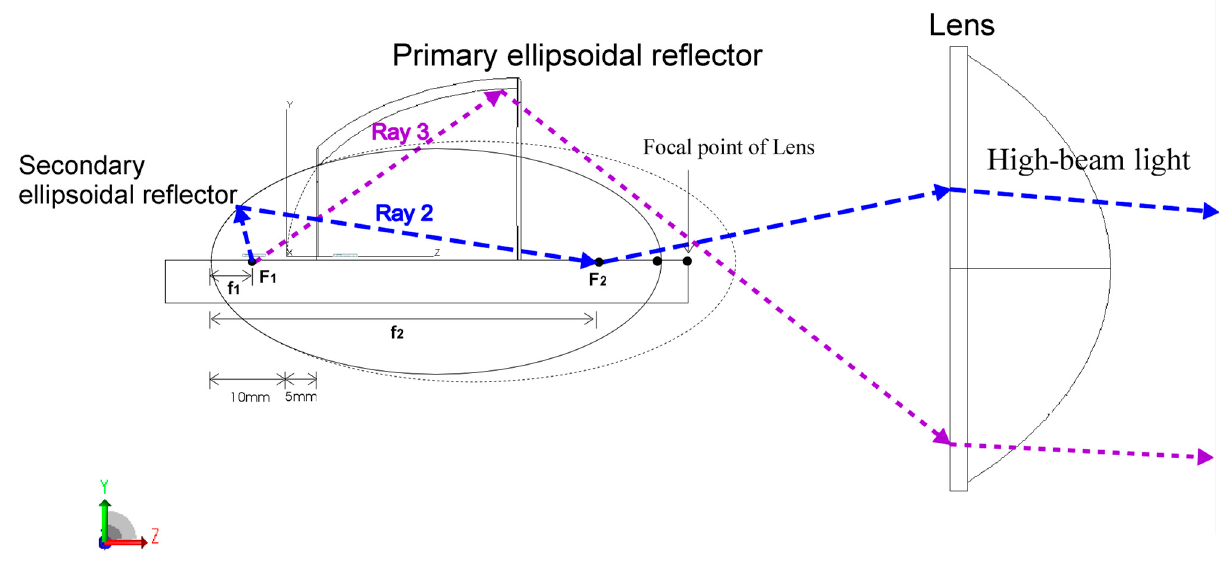
Figure 10. The design of the secondary ellipsoidal reflector in this study.